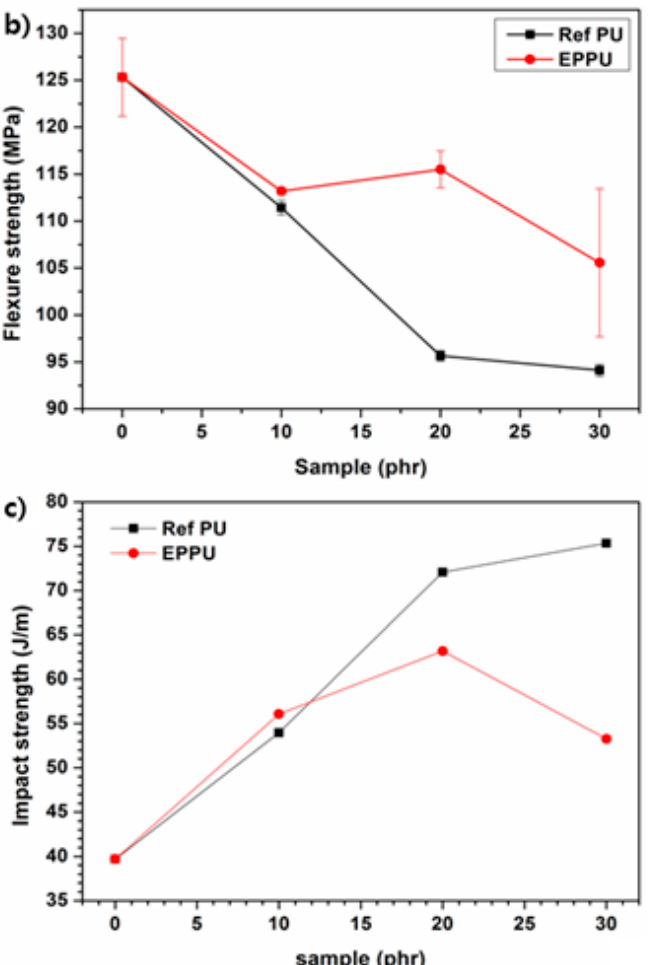
Figure 8. Mechanical strength data for epoxy composites including various amounts of Ref PU or EPPU: ( a ) tensile strength~( b ) flexural strength~and ( c ) impact resistance. phr: parts per hundred resin